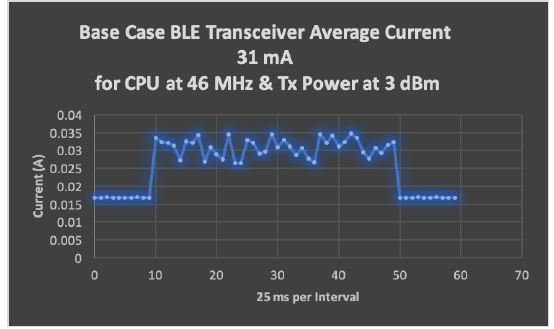
Figure 5. Base case average current.